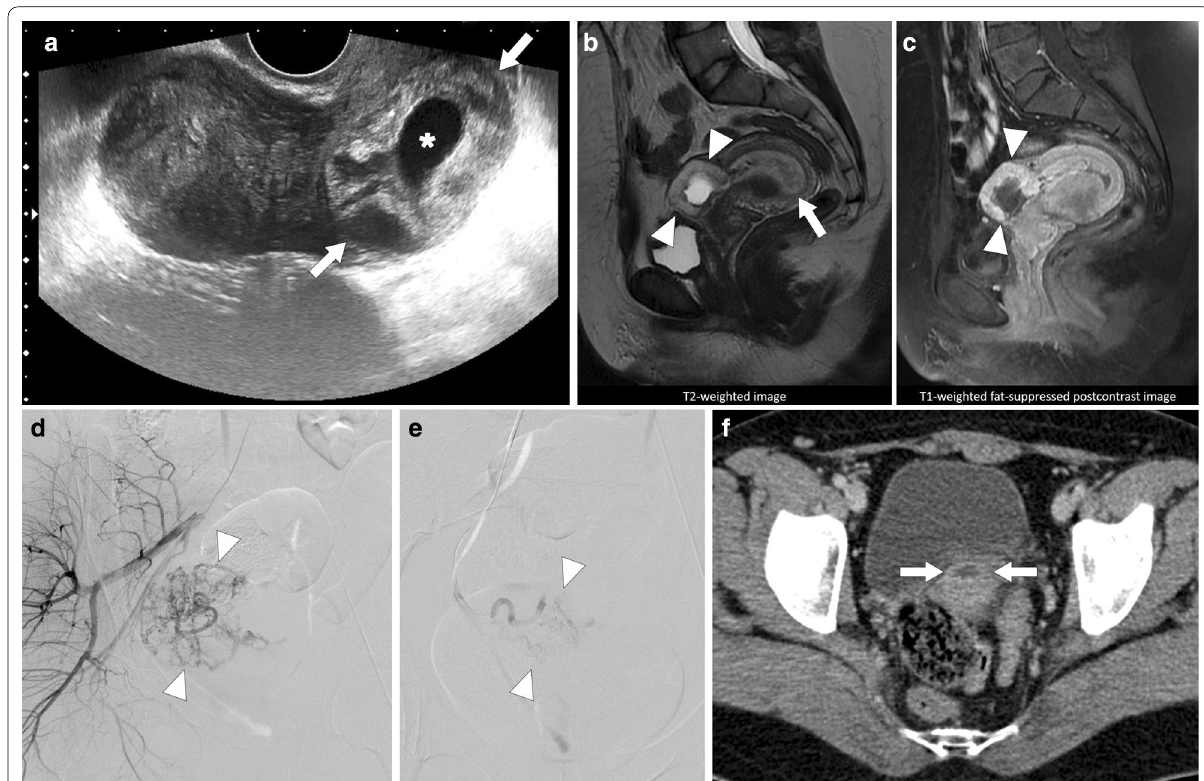
Fig. 33 Ectopic pregnancy in the cesarean scar. A 29-year-old female patient presenting with recent onset post-coital bleeding. Gynecological examination was suspicious for a cervical mass. Serum beta-hCG level was mildly elevated (2100 mIU/mL). a Transvaginal gray scale US examination clearly outlined a mass (arrows) with central cystic component (asterisk) and thick walls. There were no detectable fetal elements nor fetal cardiac activity within the cystic component of the lesion. b , c Sagittal plane T2W and T1W postcontrast images, respectively, better demonstrate the same lesion with central cystic component and intense enhancement in its thick walls (arrowheads). Also note was made of thick endometrial lining suggestive of decidual reaction (arrow). The imaging and laboratory findings were inconclusive but a conservative approach was elected as the patient expressed her desire to preserve fertility. Oral methotrexate was started and a simultaneous endoarterial embolization was performed. d Intense vascularity was noted at the site of the lesion in pre-embolization angiography (arrowheads). e The lesion becomes completely devascularized after embolization (arrowheads). Her recovery was uneventful and serum beta-hCG levels precipitously dropped after these treatments. f Axial plane postcontrast abdominal CT image 2 year after the initial presentation showed a small residual cystic lesion (arrows), and